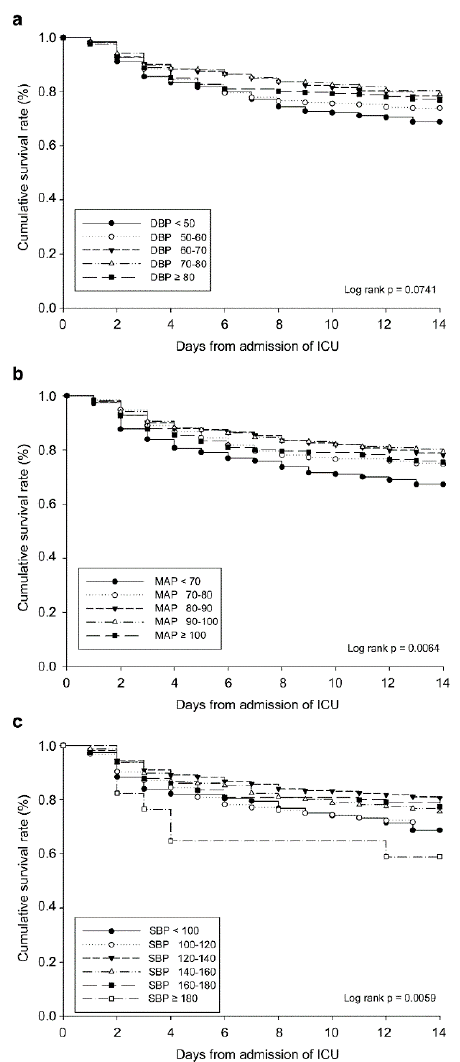
Figure 3. Kaplan–Meier comparison of mortality in patients with non-traumatic hemorrhage. ( a ) Mean arterial pressure. ( b ) Systolic blood pressure. ( c ) Diastolic blood pressure. Data were adjusted for sex, marital status, ethnicity, admission type, insurance type, care-unit, age, creatinine clearance level, diabetes mellitus, sepsis, and Sequential Organ Failure Assessment score. GCS, Glasgow Coma Scale.